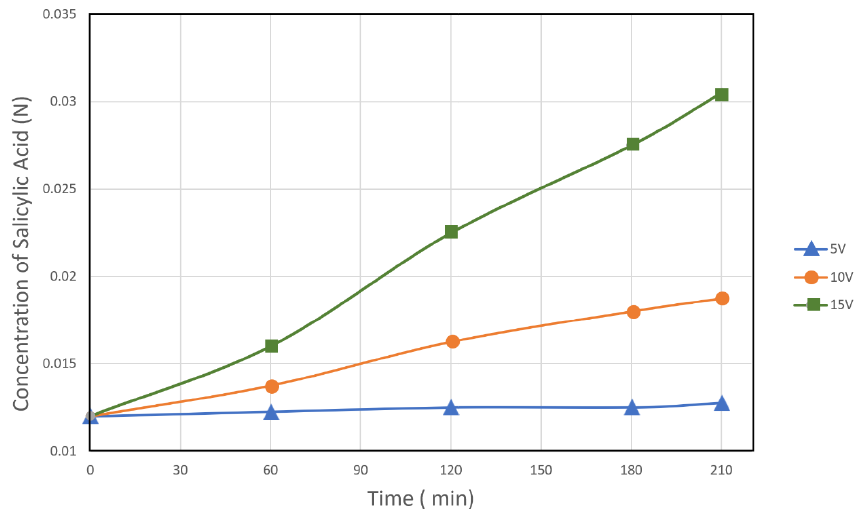
Figure 9. Salicylic acid concentration in the acid compartment at various electric potentials as a function of